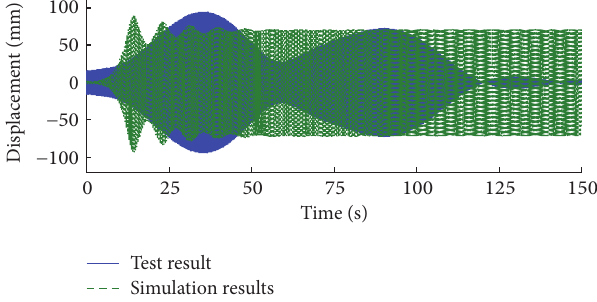
Figure 18: Contrast of the experiment and numerical stimulation of cable displacement while 𝑊 𝐵 equals 5